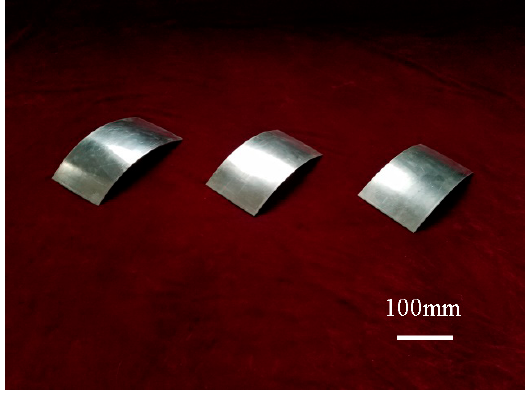
Figure 7. The formed parts with different rotation speed ratio.